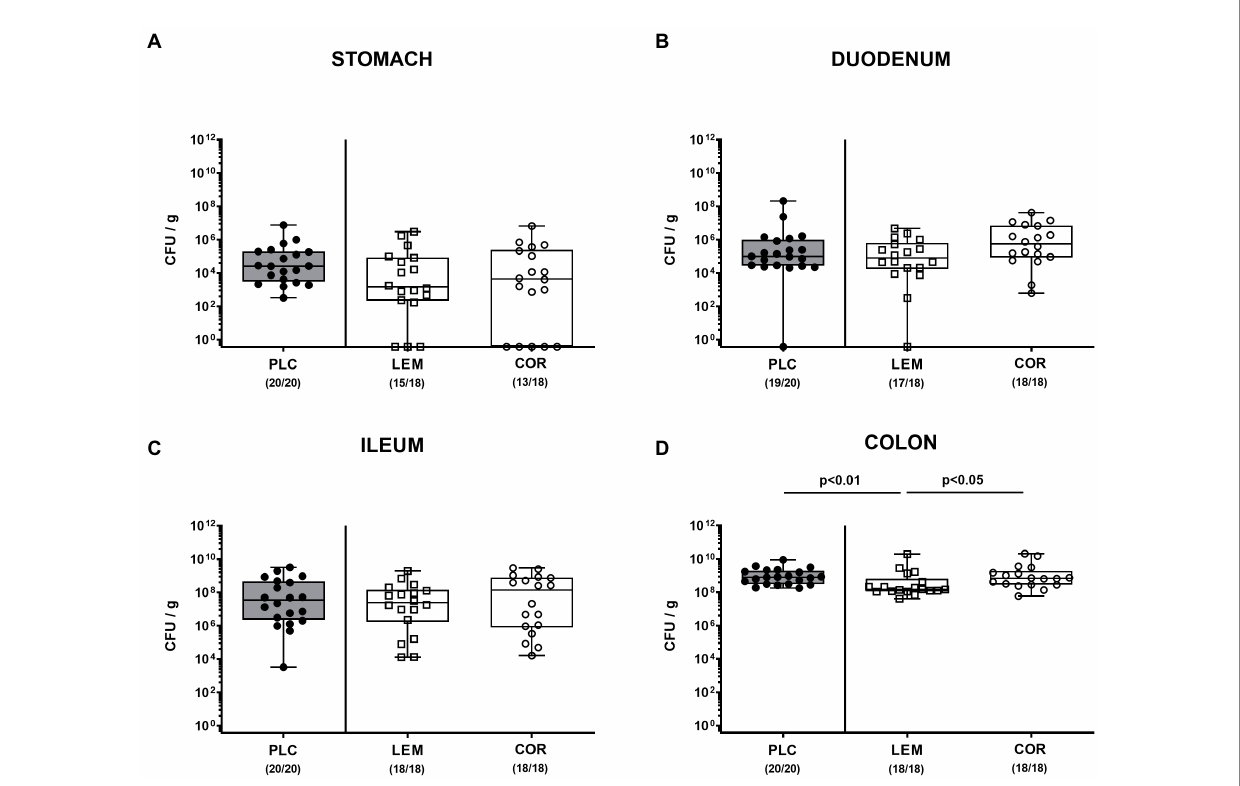
FIGURE 1 Gastrointestinal C. jejuni colonization following prophylactic oral application of lemon or coriander essential oil to infected IL-10 − / − mice. SAB IL-10 − / − mice were obtained as described in methods and subjected to prophylactic lemon (LEM; white squares) or coriander (COR; white circles) essential oil via the drinking water ( ad libitum ) starting 7 days prior infection. Placebo (PLC; black circles) control animals received tap water only. On days 0 and 1, mice were then perorally infected with C. jejuni strain 81–176 by gavage. The C. jejuni numbers (colony forming units per gram; CFU/g) were assessed in distinct gastrointestinal luminal samples from the (A) stomach, (B) duodenum, (C) ileum, and (D) colon taken following sacrifice of mice at day 6 post-infection. Box plots (indicating the 25th and 75th percentiles), whiskers (indicating the minimum and maximum values), medians (black bar inside box) and numbers of culture-positive mice out of the total number of analyzed animals (in parentheses) are shown. Significance levels ( p values) were calculated by the Kruskal–Wallis test with Dunn’s post-correction using pooled data from four independent